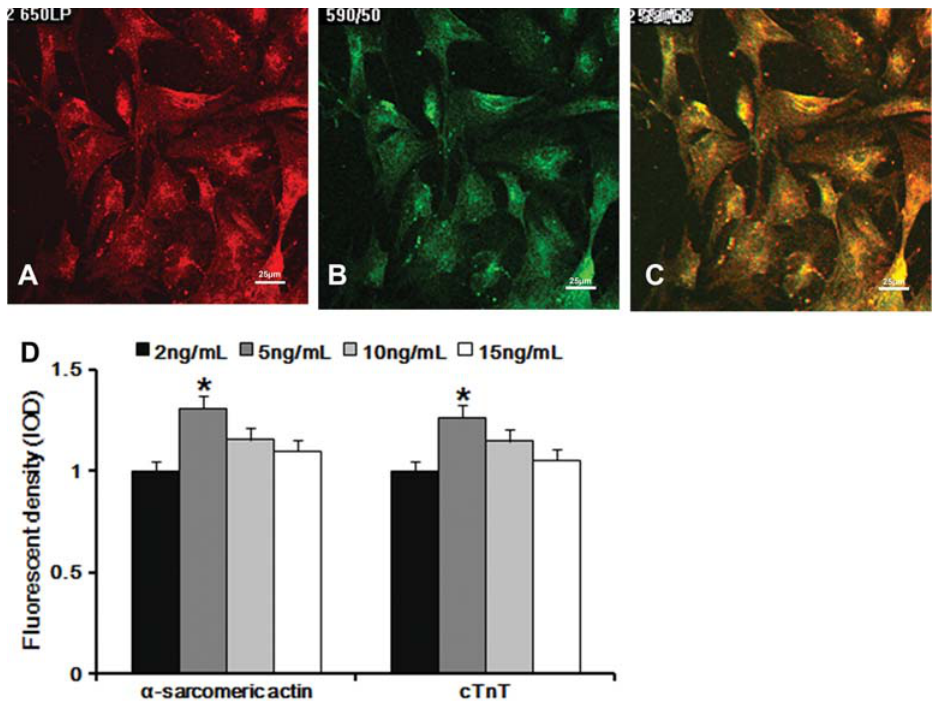
Figure 2. Laser scanning confocal microscopy results used to investigate double labeling of a -sarcomeric actin and cTnT proteins in rat bone marrow mesenchymal stem cells (rBMSCs) treated with 5 ng/mL TGF- b 1, evaluated by fl uorescence. A , Red light indicating a - sarcomeric actin; B , green light indicating cTnT; C , the presence of both proteins was indicated by yellow light; D , bar graphs showing the double labeling of a -sarcomeric actin and cTnTof rBMSCs treated with different concentrations of TGF- b 1. Magni fi cation bar: 25 m m. Data are reported as means ± SD. *P o 0.05 vs 2 ng/mL group (one-way